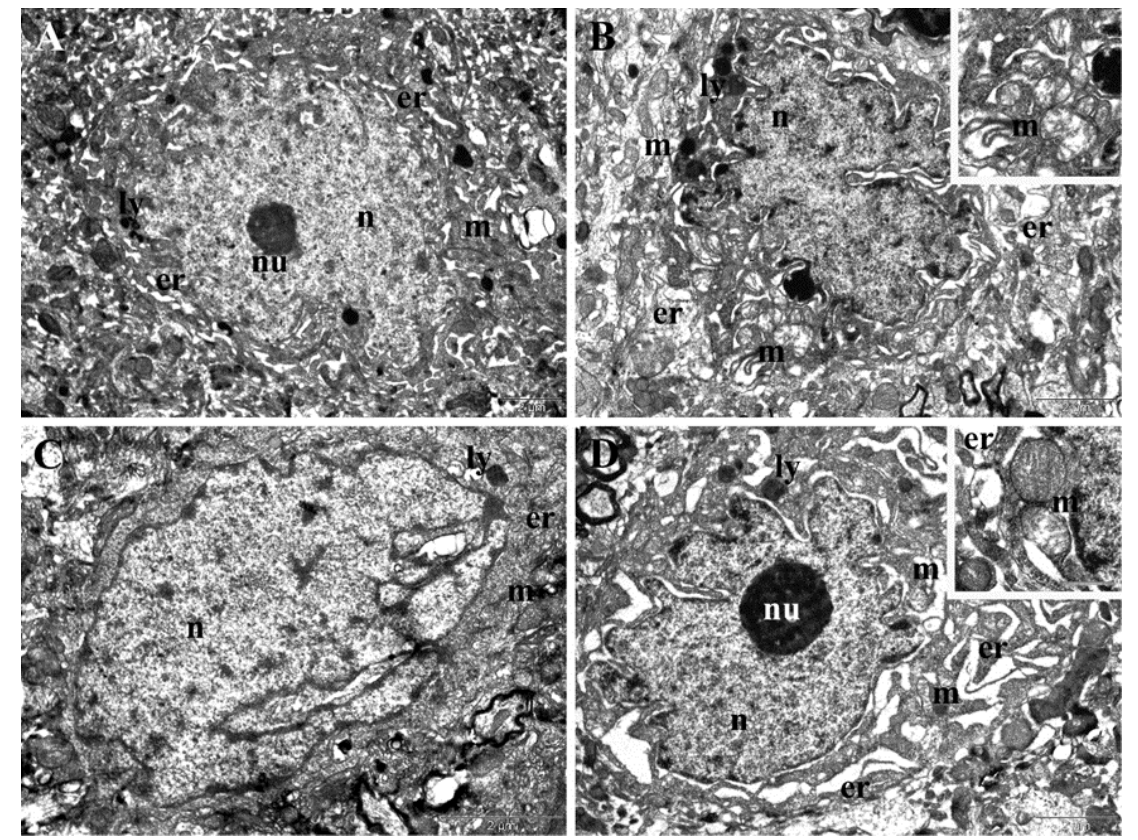
Figure 10. TEM images presenting ultrastructural changes recorded at the end of the experimental treatment. ( A ) Neurons from frontal cortex of rats treated with the low dose of NPs (T45 D1 group). ( B ) Neurons from the hippocampus of rats treated with the low dose of NPs (T45 D1 group). ( C ) Neurons from the frontal cortex of rats treated with the high dose of NPs (T45 D2 group). ( D ) Neurons from the hippocampus of rats treated with the high dose of NPs (T45 D2 group). er–endoplasmic reticulum; ly–lysosome; m–mitochondrion; n–nucleus; nu–nucleolus; rbc–red blood cell.